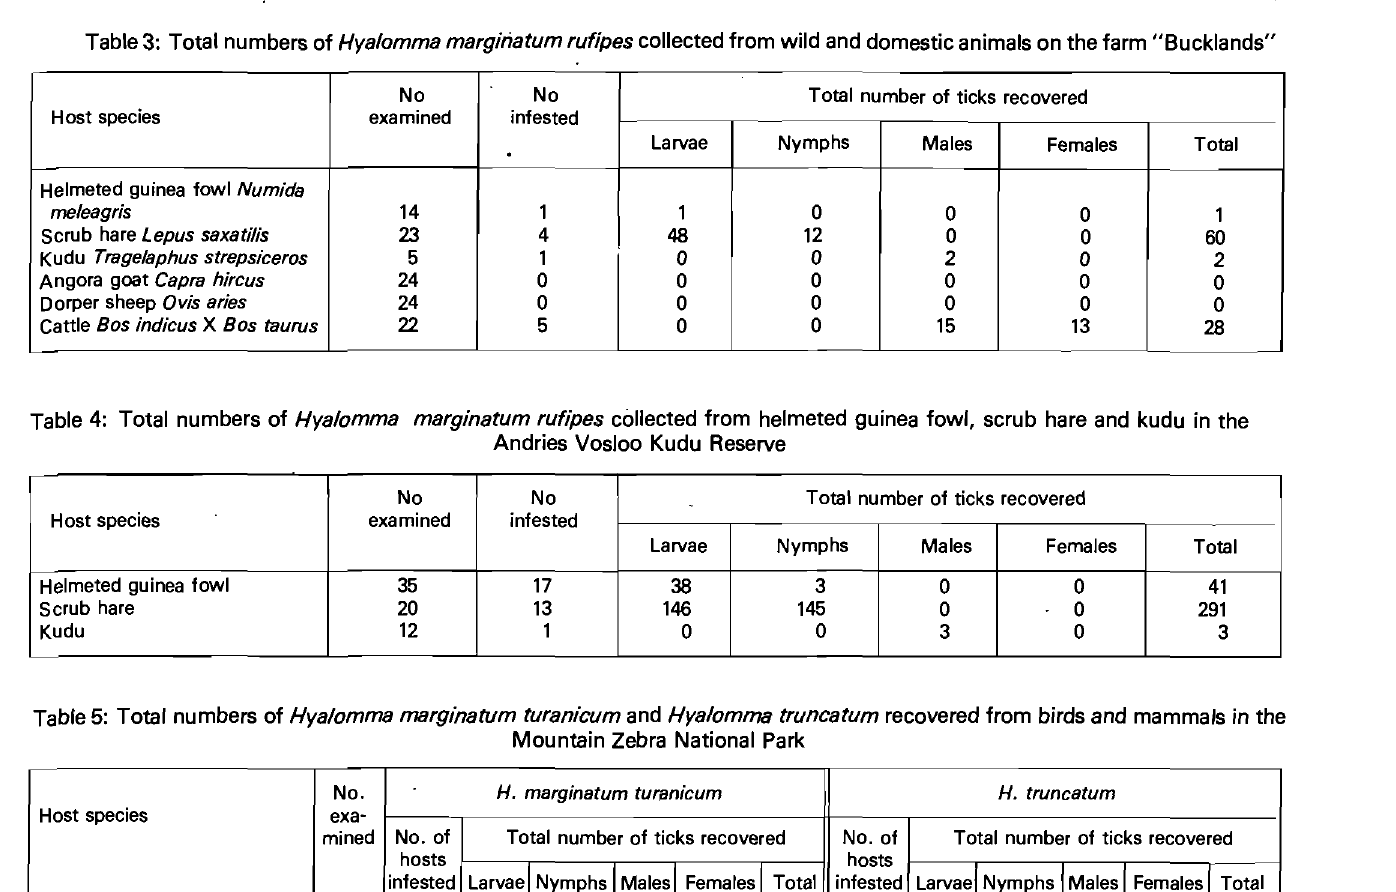
Table 5: Total numbers of Hyalomma marginatum turanicum and Hyalomma truncatum recovered from birds and mammals in the Mountain Zebra National Park No. H. marginatum turanicum H. truncatum Host species exa- mined No. of Total number of ticks recovered No. of Total number of ticks recovered